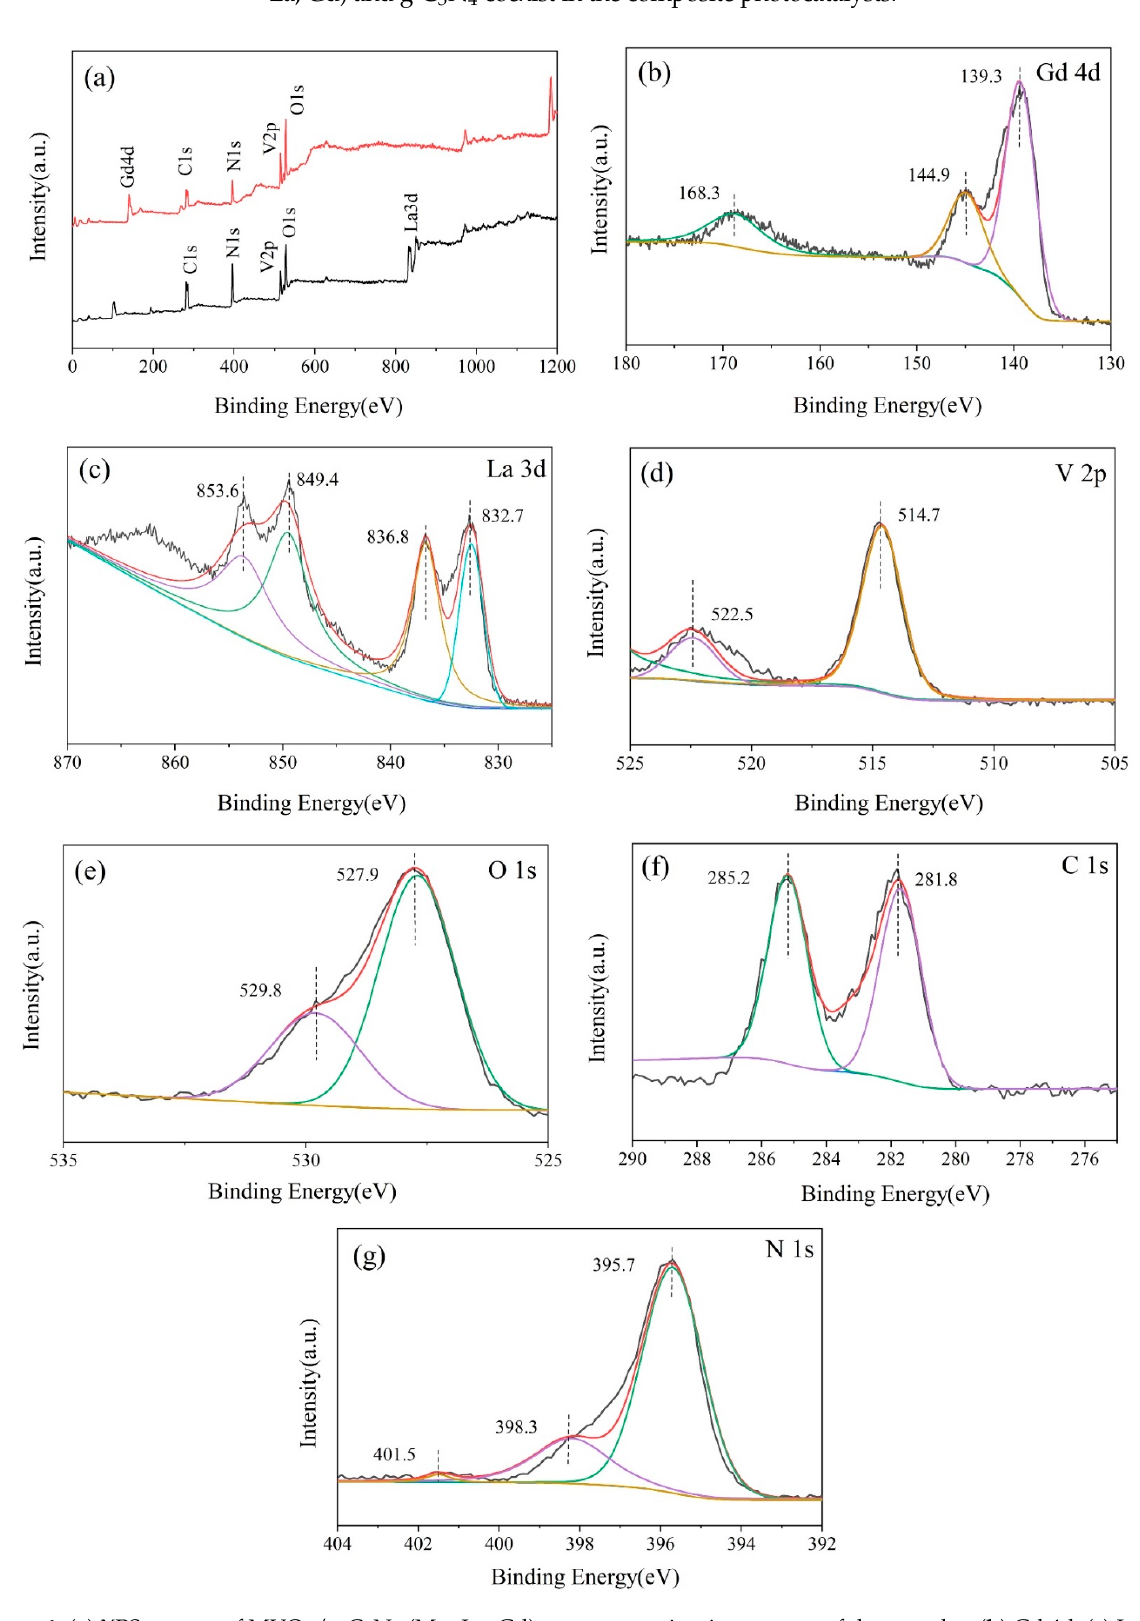
Figure 4. ( a ) XPS spectra of MVO 4 /g-C 3 N 4 (M = La, Gd) nanocomposites in a survey of the samples, ( b ) Gd 4d, ( c ) La 3d, ( d ) V 2p, ( e ) O 1s, ( f ) C 1s, and ( g ) N